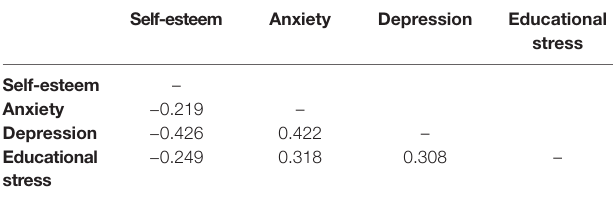
TABLE 3 | Pearson correlations between self-esteem, anxiety, depression, and educational